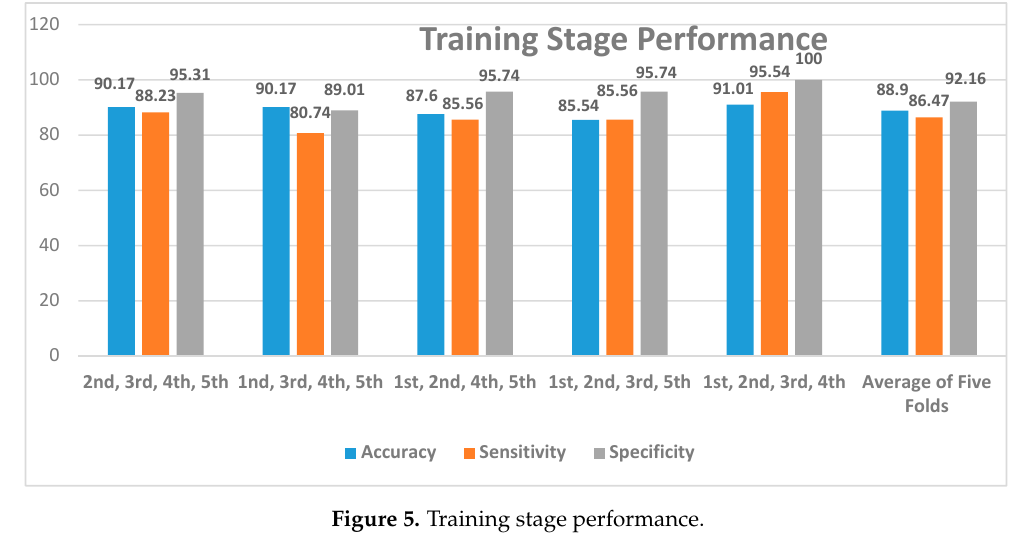
Figure 5. Training stage performance. Energies 2017 , 10 , 1987